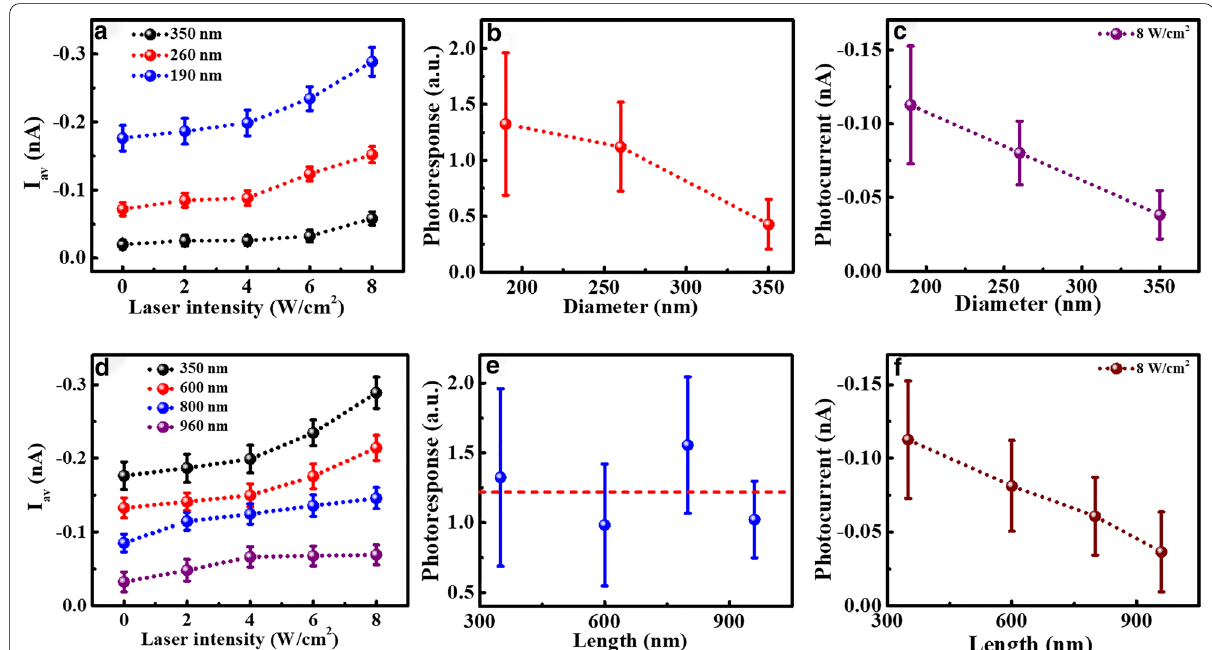
Fig. 3 a The averaged current ( I av ) of Si NWs with different diameters as a function of laser intensity. b The averaged photoresponse over the laser intensities as a function of diameters. c The dependence of photocurrent on diameter at the laser intensity of 8 W/cm 2 . d The I av of Si NWs with different lengths as a function of laser intensity. e The averaged photoresponse over the laser intensities as a function of length. f The dependence of photocurrent on length at the laser intensity of 8 W/cm